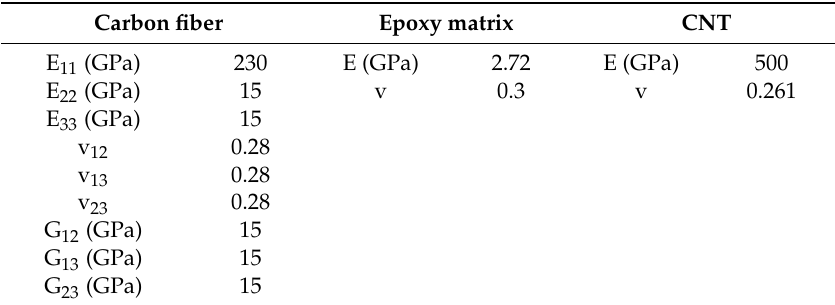
Table 1. Material